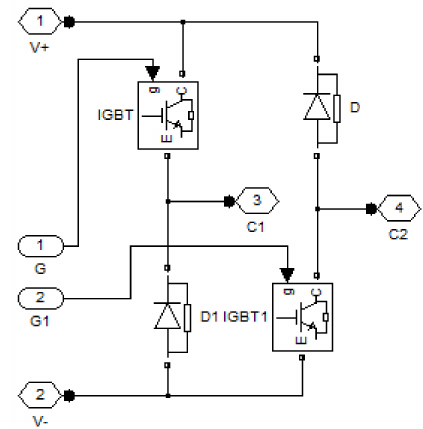
Figure 9. IGBT driver module.